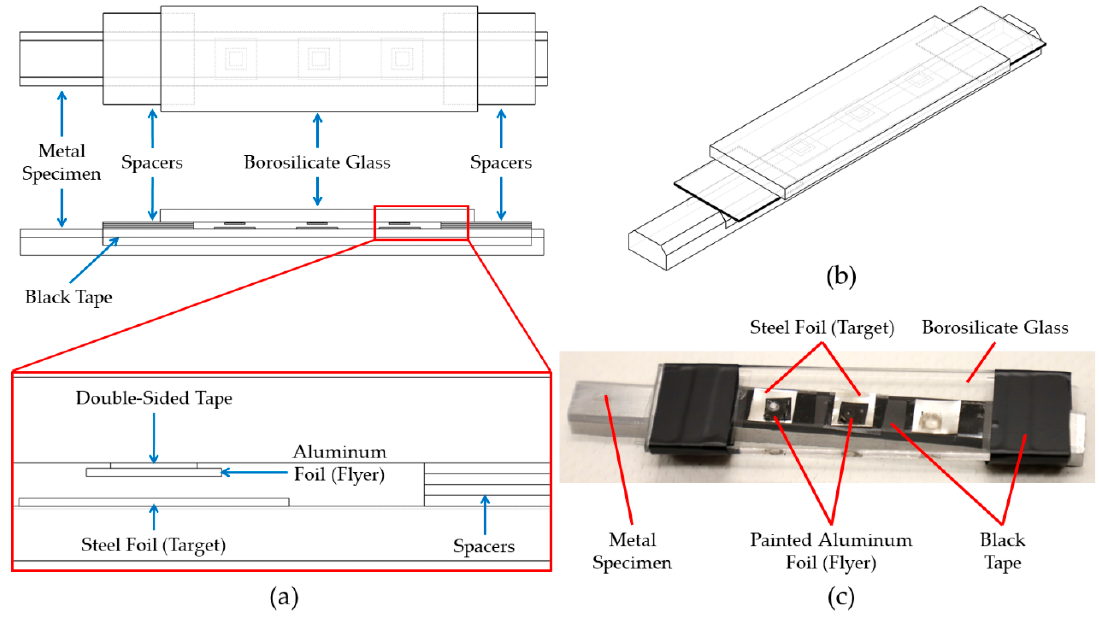
Figure 2. Structure of a LIW specimen: ( a ) Schematic of the LIW specimen (top and side views); ( b ) Schematic of the LIW specimen (isometric view); ( c ) An actual LIW specimen after laser impact. A Spectra-Physics Quanta Ray Pro-350 infrared laser system (technical specifications listed